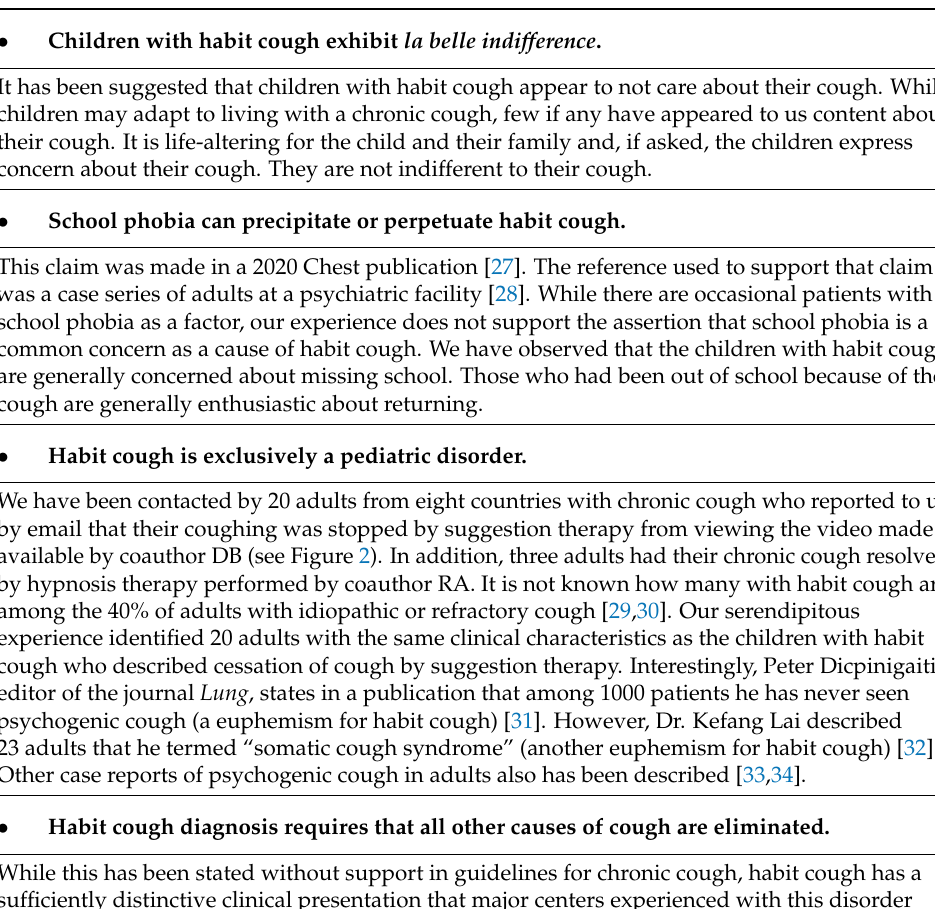
Table 1. Popular factoids and actual facts regarding habit